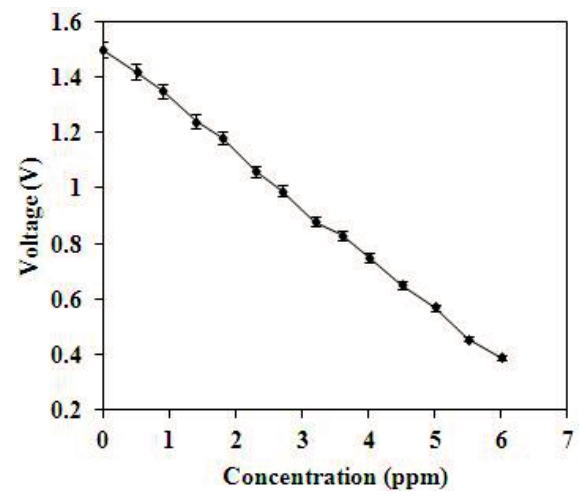
Figure 12. Test of the methanol sensor.